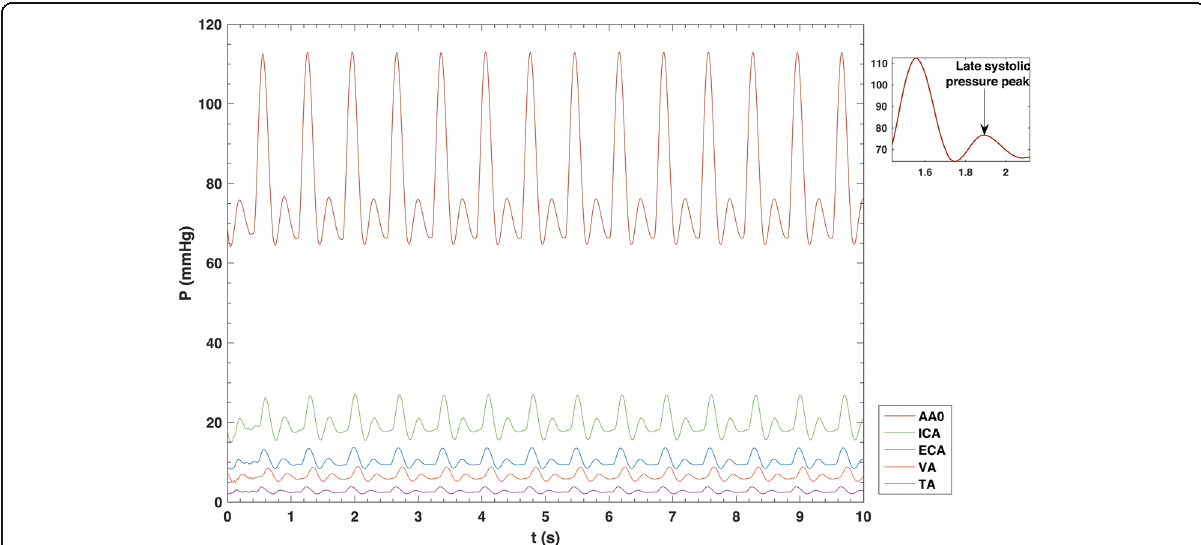
Fig. 3 Cardiac and arterial pressure waveforms. The inset shows the zoom of one cardiac cycle. AAo Ascending aorta, ECA Extracranial artery,